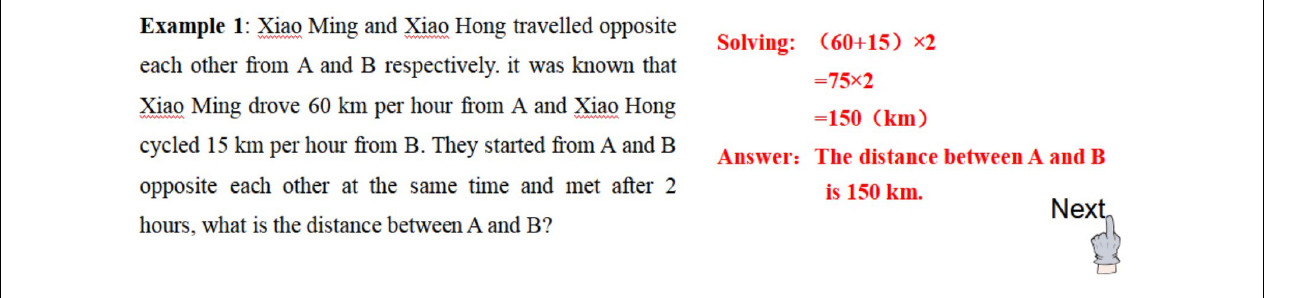
FIGURE 1 | No subgoal-worked example.